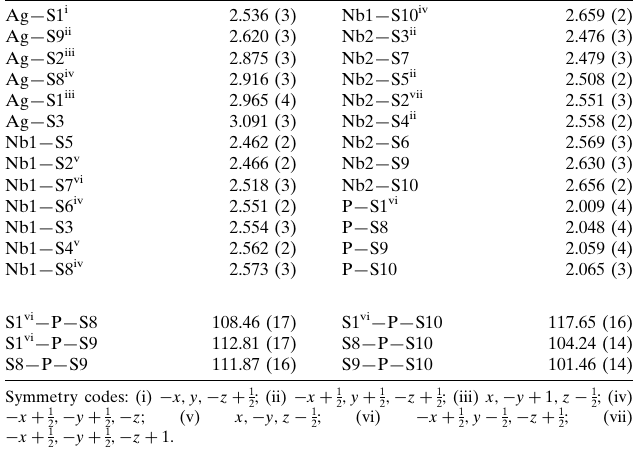
Selected geometric parameters (A˚ , (cid:3)